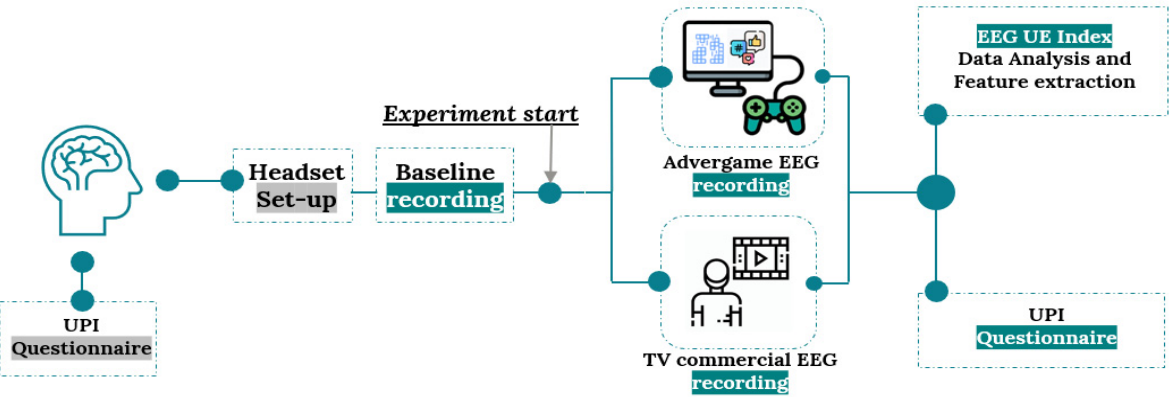
Figure 4. Experiment setup.